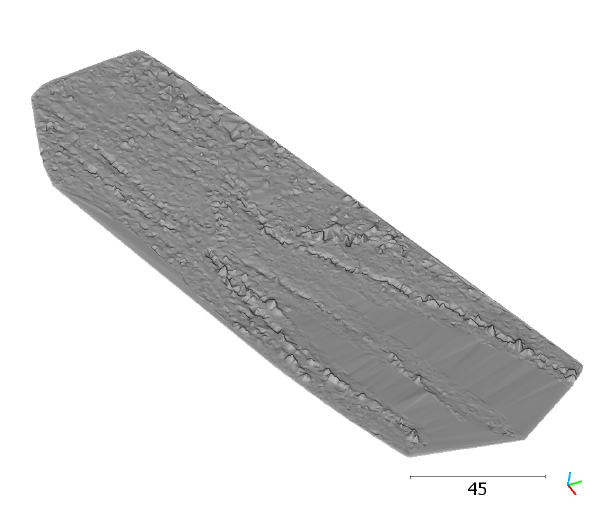
Figure 4. Mesh which is used as a scene model in the simulation, with displacement predicted from the Kalman smoother after five days. Displacement values are multiplied by a factor of 20 for this visualisation.